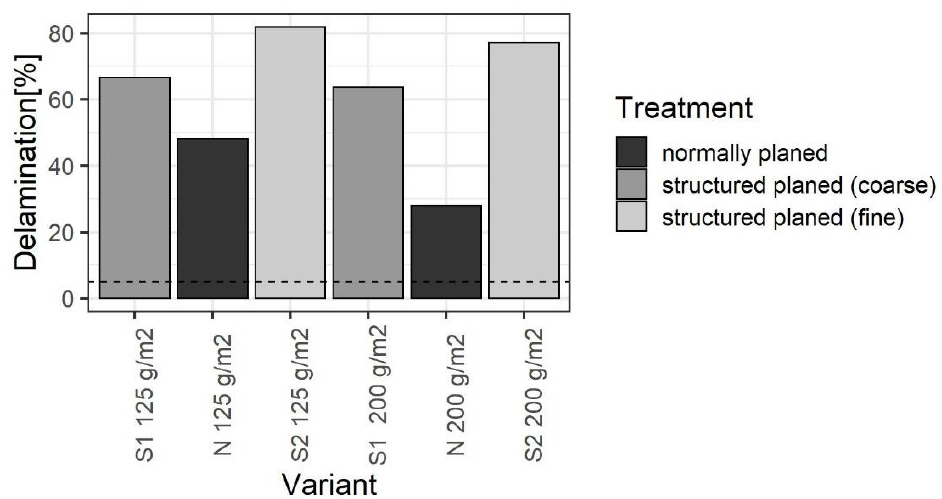
Figure 6. Delamination results for one-component polyurethane without chemical pre-activation treatment of hardwood. The bars represent the arithmetic mean value; the dashed line shows the maximum value of delamination accepted according to the employed standard.